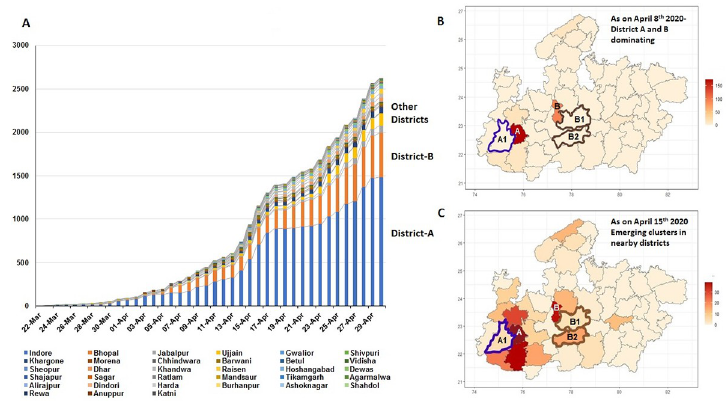
Fig 1. COVID-19 time trends in districts of Madhya Pradesh. A) Composite bar charts showing proportional distribution of COVID-19 cases in districts of Madhya Pradesh where district A (Indore) and district B (Bhopal) were contributing to majority of cases with emergence of other clusters in the month of April. B) Choropleth map for case density of Madhya Pradesh showing district A and B in darker shades as on 8 th April 2020. C) Choropleth map for case density of Madhya Pradesh after removing polygons for district A and B (white shades) as on 15 th April 2020 (emergence of cases in the adjacent districts are reflected by a darker shades). Pooling strategy was evaluated for the emerging clusters, neighboring district A [A1 (Dhar) blue skeleton cluster] and district B [B1 (Raisen), B2 (Hoshangabad) brown skeleton clusters].